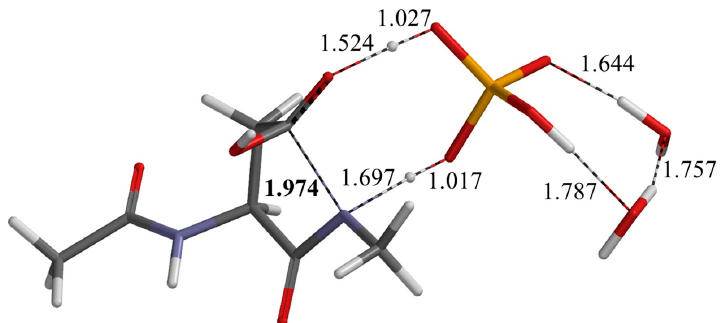
Figure 4. The geometry of the first-step transition state (TS1). This transition state is for cyclization, and connects the RC (Figure 3) and the first tetrahedral intermediate complex (IC1) (Figure 5). Selected interatomic distances are shown in Å. Grey: carbon; white: hydrogen; blue: nitrogen; red: oxygen; orange: phosphorus.